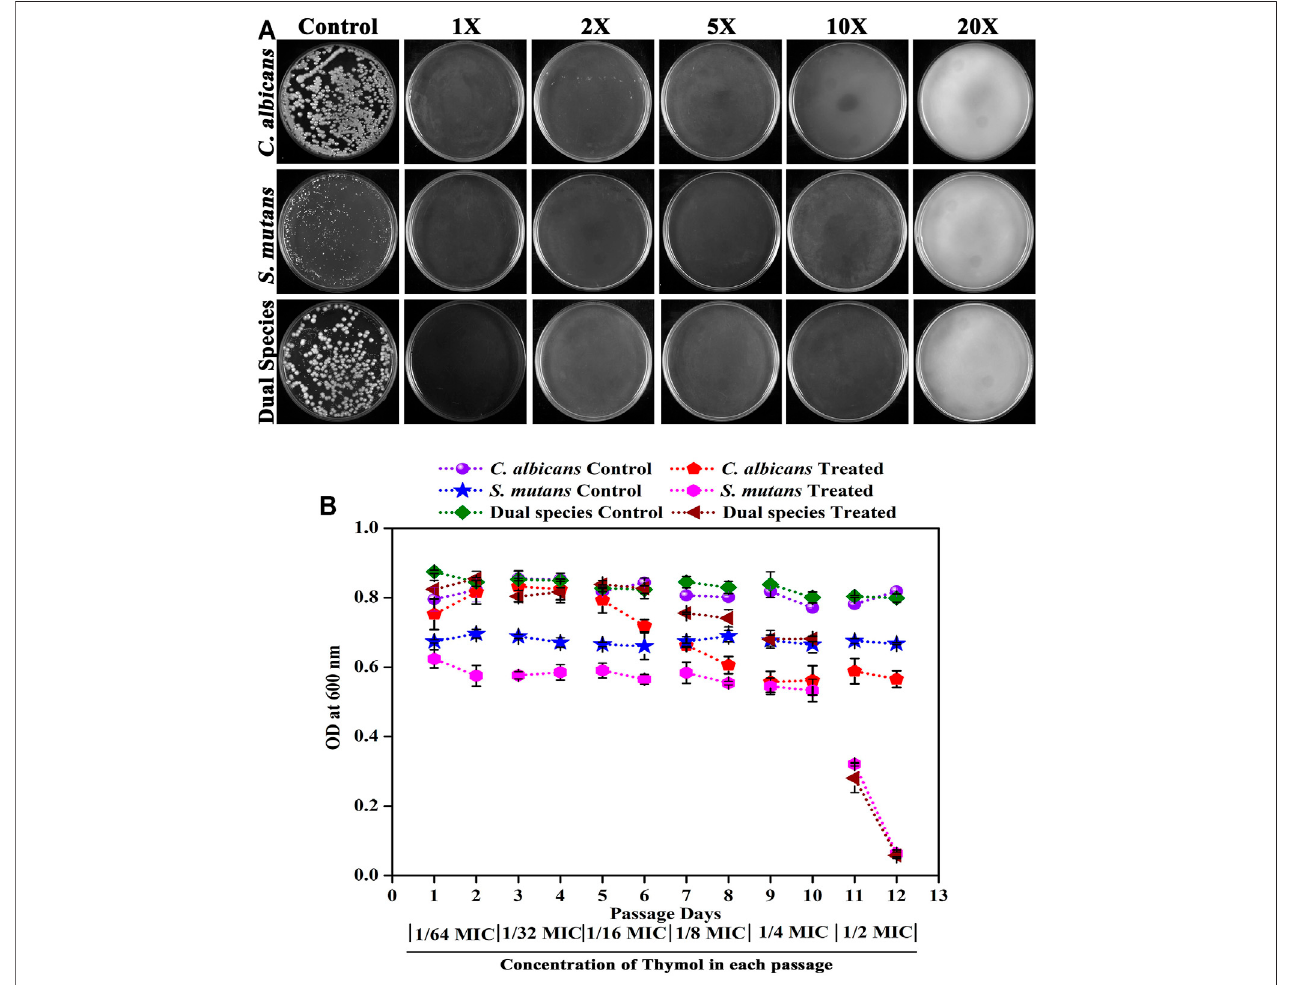
FIGURE 6 | Assessment of the ability of the pathogens to develop resistance against thymol. (A) Spontaneous resistance development. Both single and dual species of C. albicans and S. mutans did not develop spontaneous resistance to thymol even at 20X MIC. (B) Resistance development in successive passage. Subculturing of pathogens with increasing concentrations of thymol did not initiate resistance development. Error bars represent standard deviations from the mean.